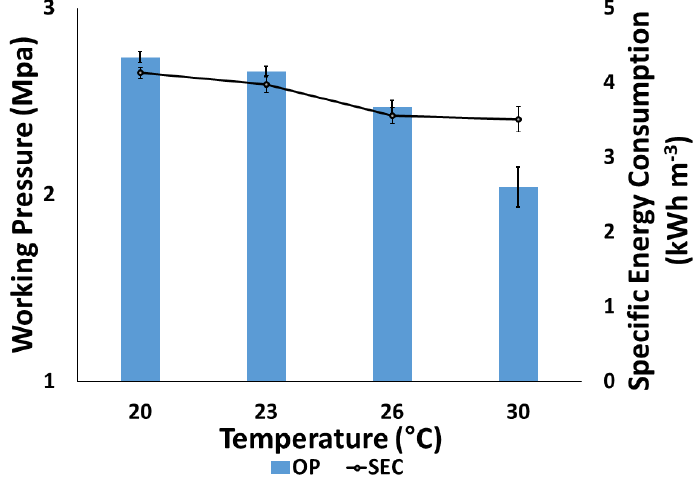
Figure 4. Working pressure and specific energy consumption.